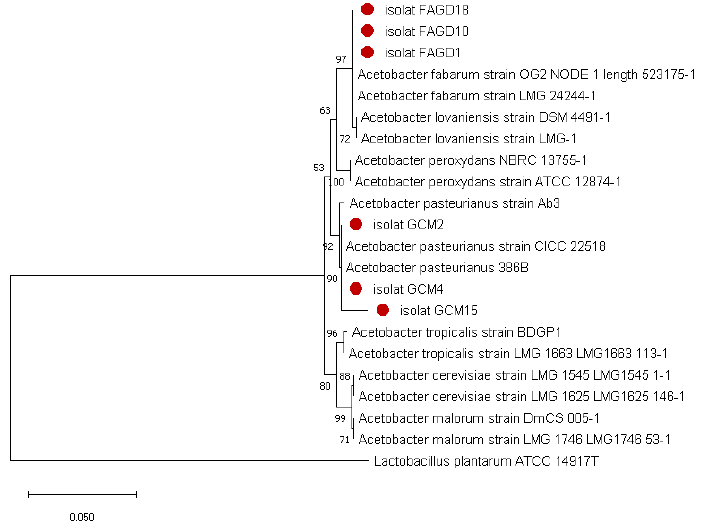
Figure 2. Phylogenetic relationships of the six strains and AAB species based on 16S rRNA gene sequences. Lactobacillus plantarum was used as outgroup.